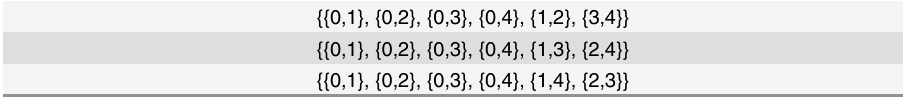
Table 3. All edge sets that are isomorphic to orbit representative